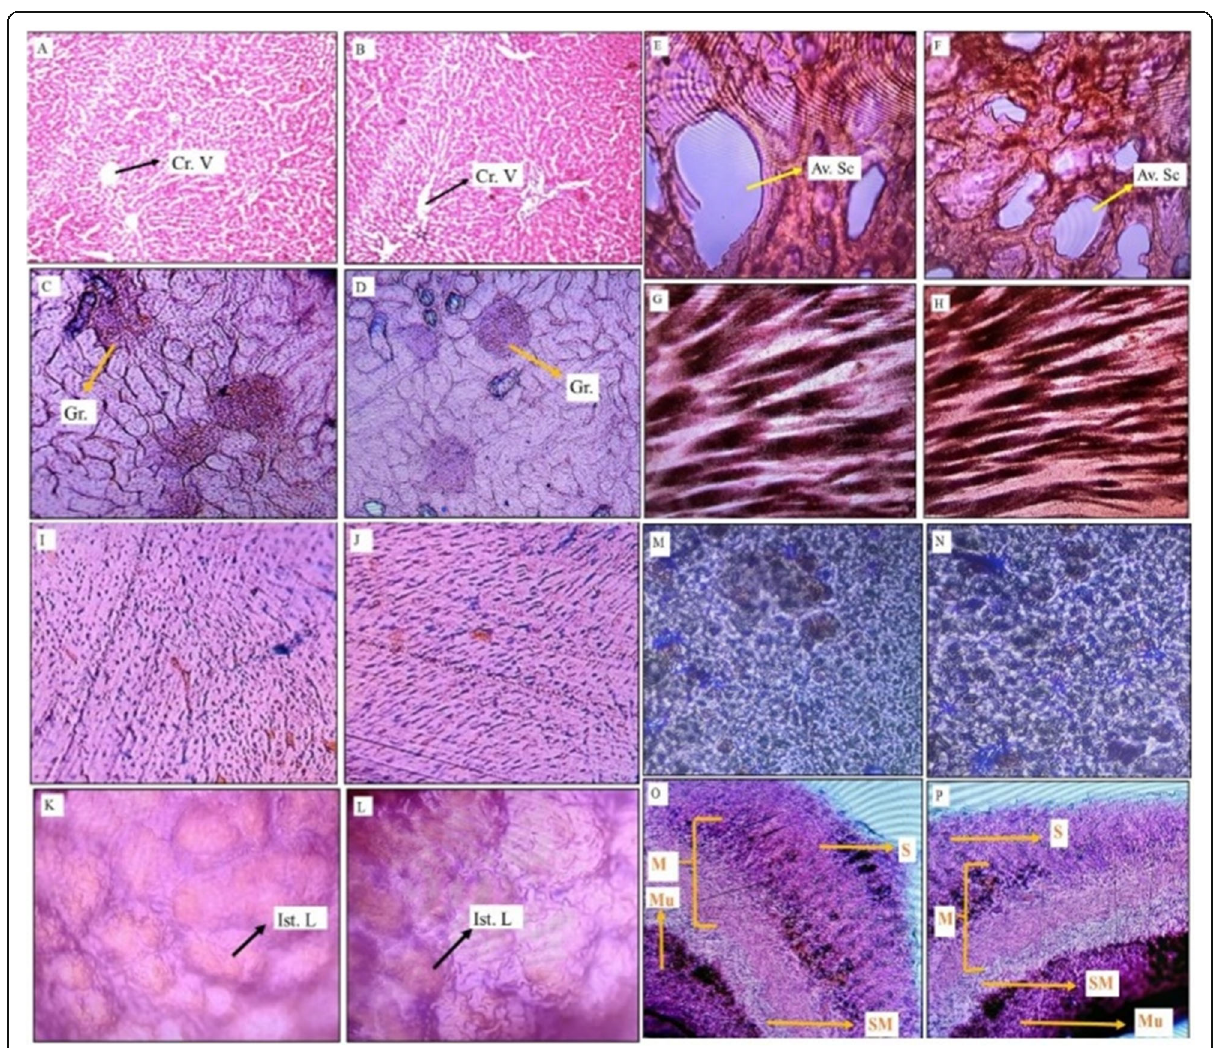
Fig. 7 Photomicrograph of organ sections of rats administered with normal saline and MA (1000 mg/kg) for 28 days. Histomorphologies of normal group rats — A, liver; C, kidney; E, alveolar sac; G, brain; I, cardiac cells; K, pancreatic cells; M, spleen; O, stomach. Histomorphologies of M. alba treated rats — B, liver; D, kidney; F, alveolar sac; H, brain; J, cardiac cells; L, pancreatic cells; N, spleen; P, stomach. Cr. V central vein; Gr. glomerulus; Av. Sc alveolar sac; Ist. L islet cells of Langerhans; Mu mucosa; SM sub mucosa; M muscularis; S